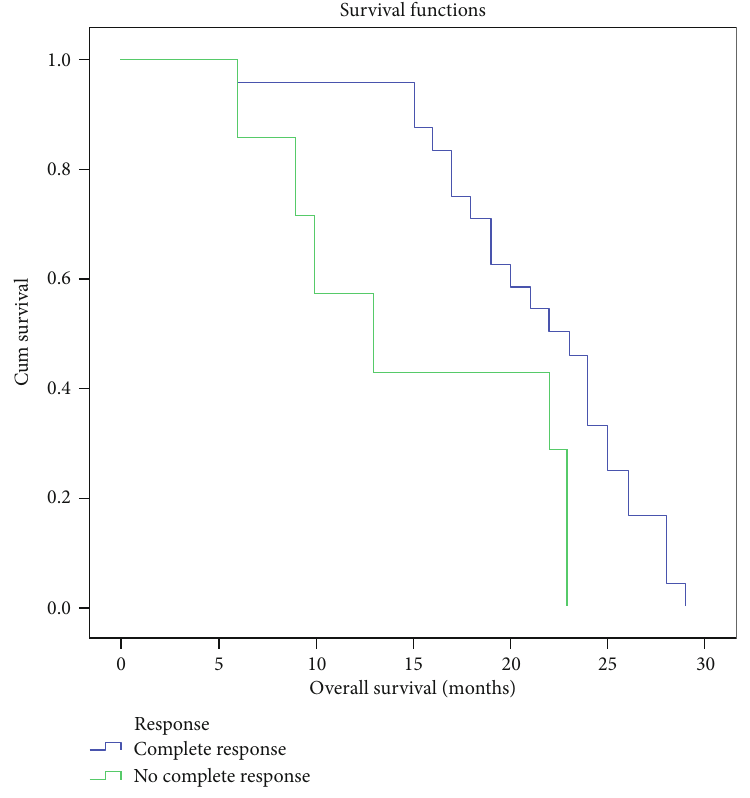
Figure 11: OS for di ff erent response groups of B-cell